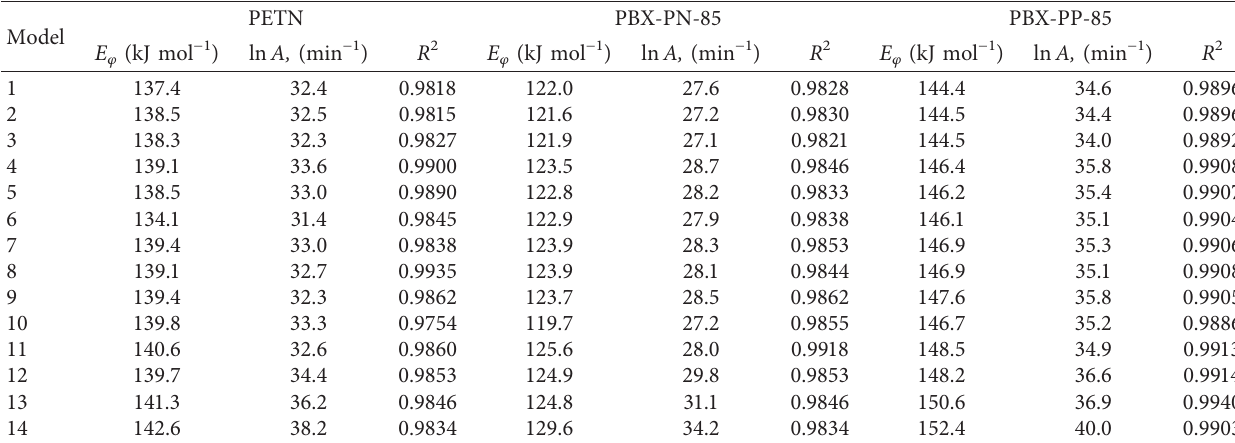
Table 6: Kinetic parameters of PETN and PBXs calculated from the model-fitting